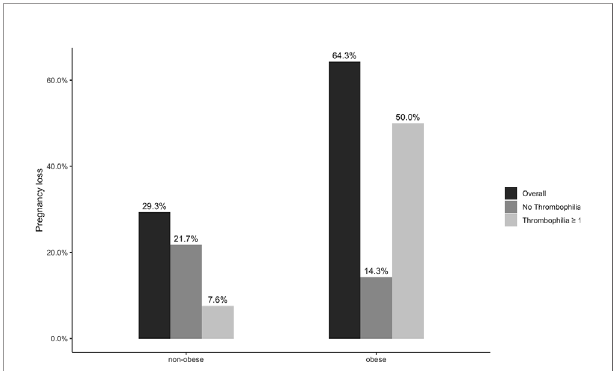
FIGURE 1 | Risk of abortion in non-obese and obese patients according to the presence of